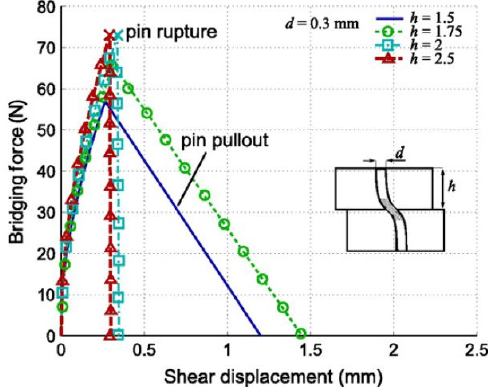
F igure 19. Effect of z-Pin embedment depth on mode II z-Pin response (CFRP z-